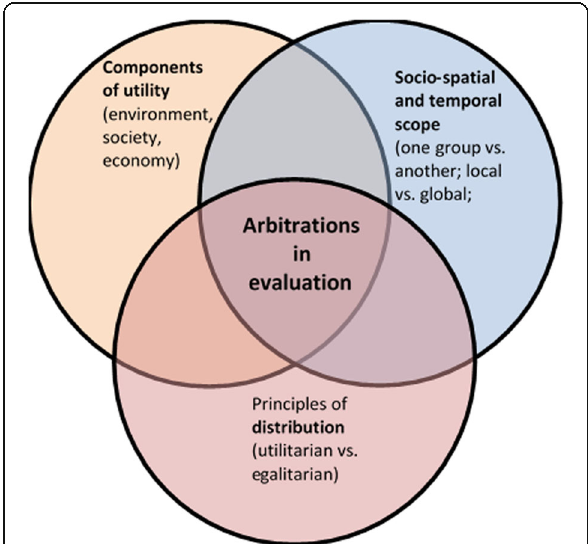
Fig. 3 Arbitrations in evaluation. Figure by